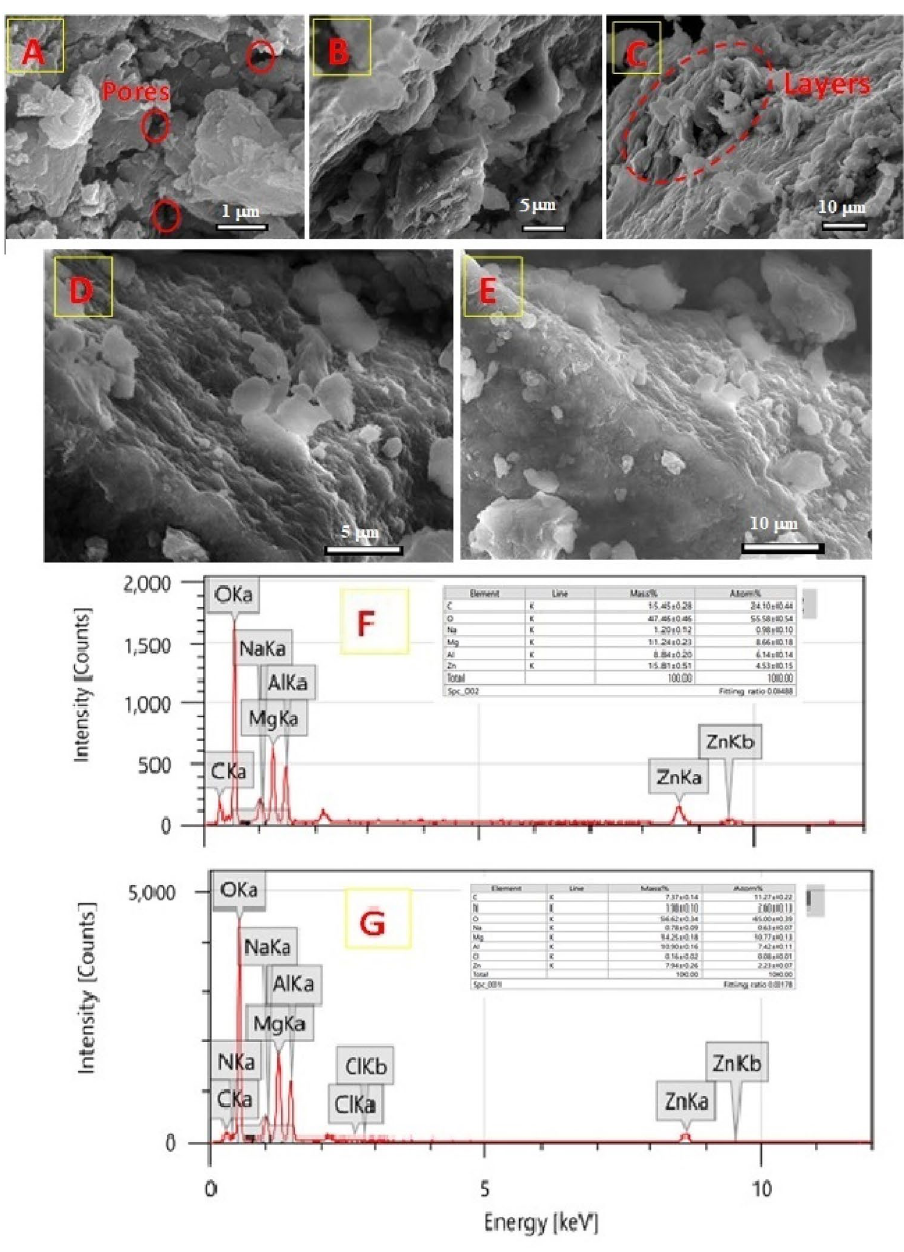
Figure 3. SEM images of Zn–Mg–Al/LDH ( A – C ) as prepared, ( D , E ) after CV adsorption, ( F ) elemental components of prepared LDH, and ( G ) elemental components of LDH after CV